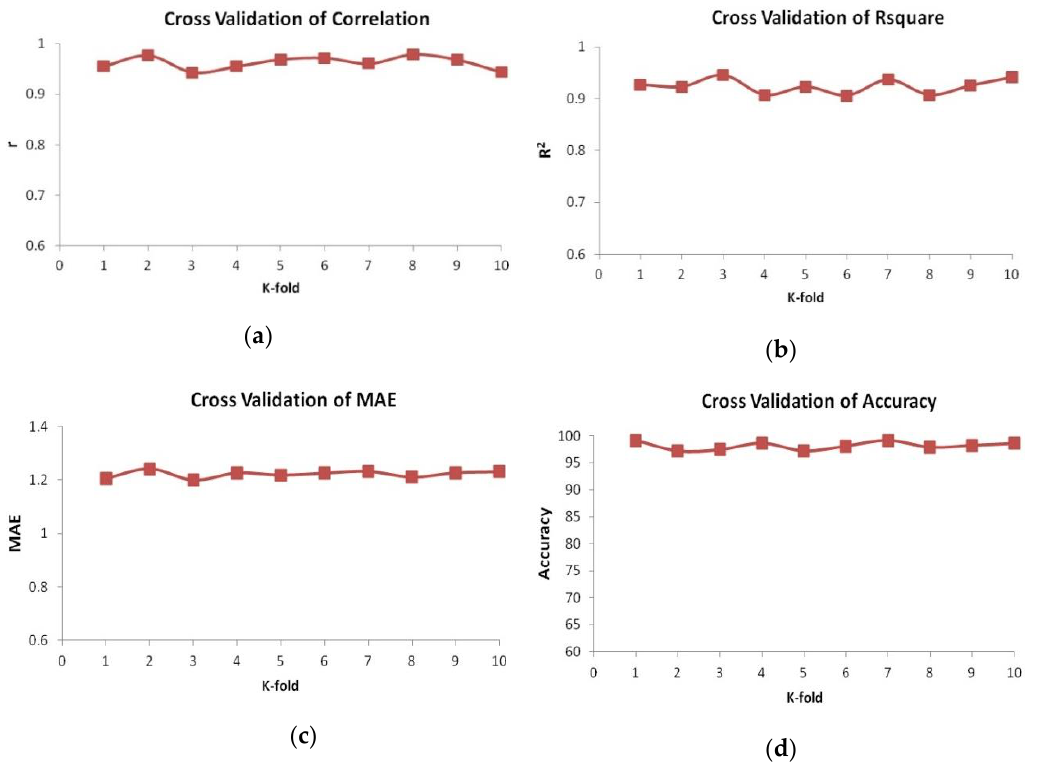
Figure 7. K-fold cross validation: ( a ) correlation; ( b ) coefficient of determination; ( c ) mean absolute error; ( d ) accuracy.